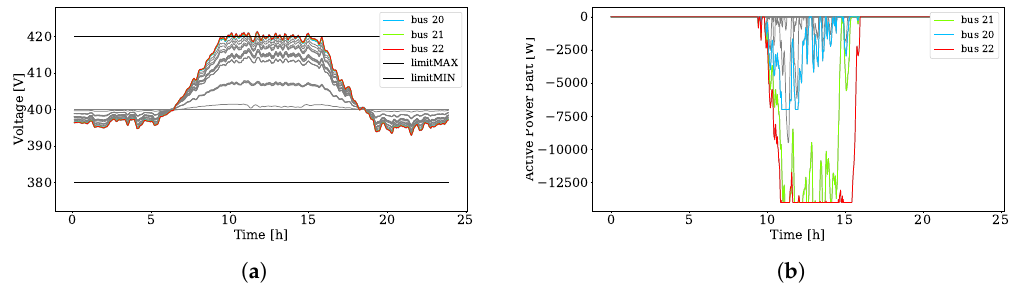
Figure 12. Results for the designed control strategy under cloudy sky conditions. ( a ) Voltage profile. ( b ) Active power injected by